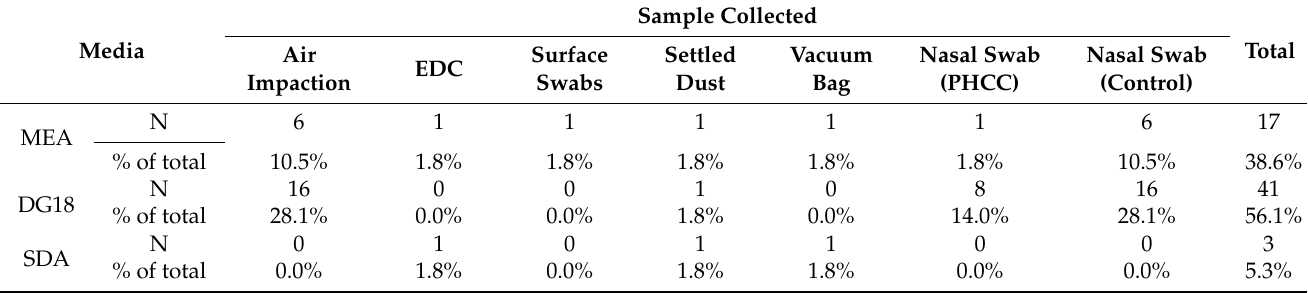
Table 2. Isolates (n) of Aspergillus section Fumigati recovered per sample collected and media applied for first isolation.